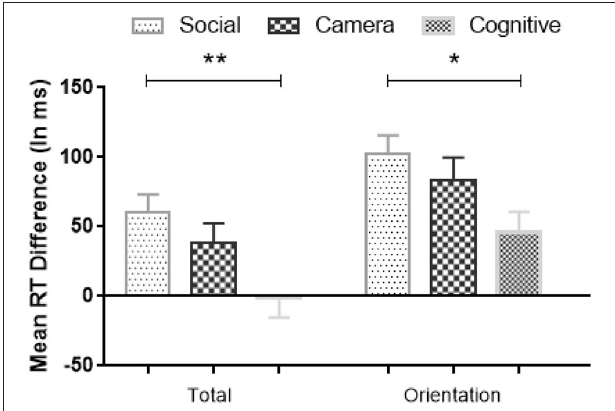
FIGURE 7 | Mean RTs differences (Random minus Standard block) in sequence-specific implicit learning across Conditions; The larger the RT difference score, the stronger the sequence-specific implicit learning effect. Error bars = Standard errors of the mean. * p < 0.05; ** p <